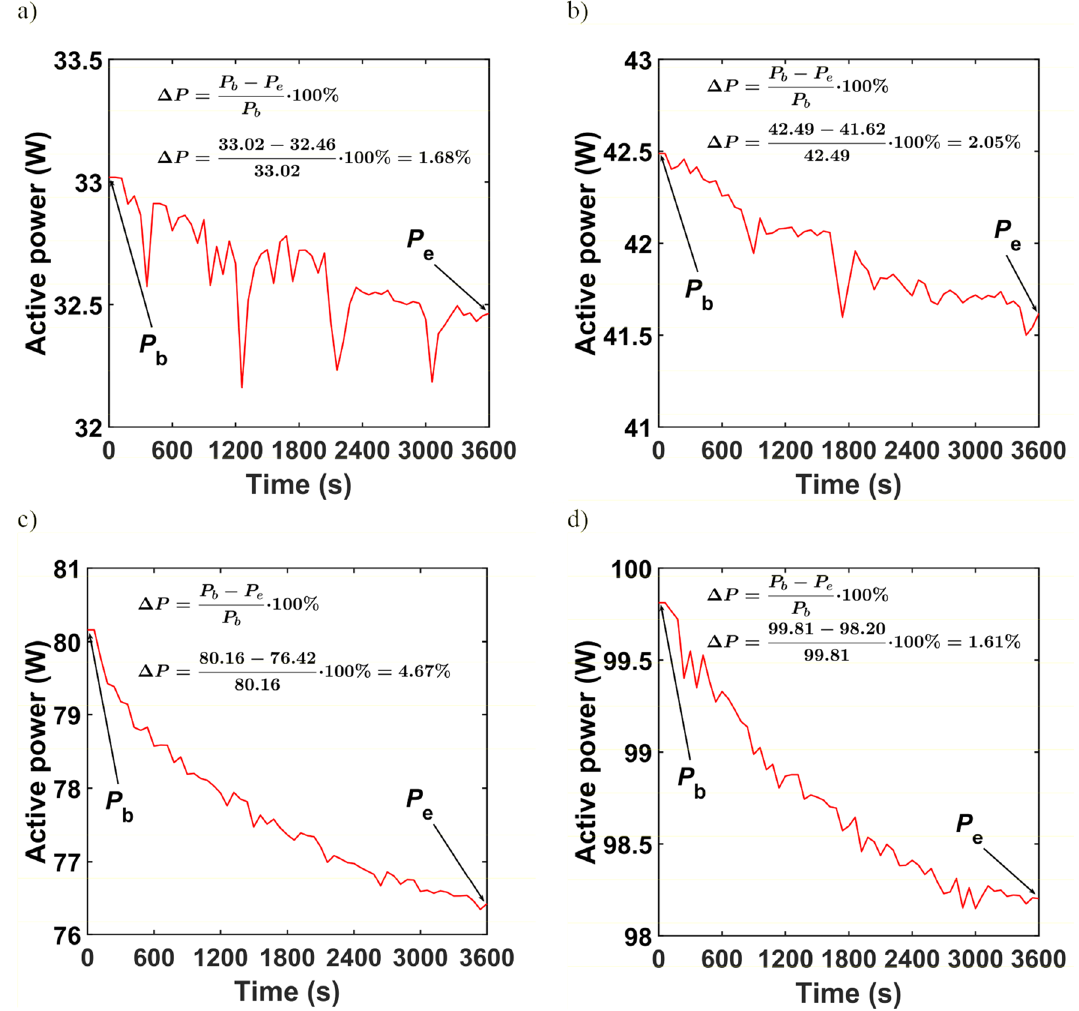
Figure 3. Active power during stabilisation of thermal conditions for ( a ) L1 lumianire, ( b ) L2 luminaire, ( c ) L3 luminaire, ( d ) L4 luminaire.